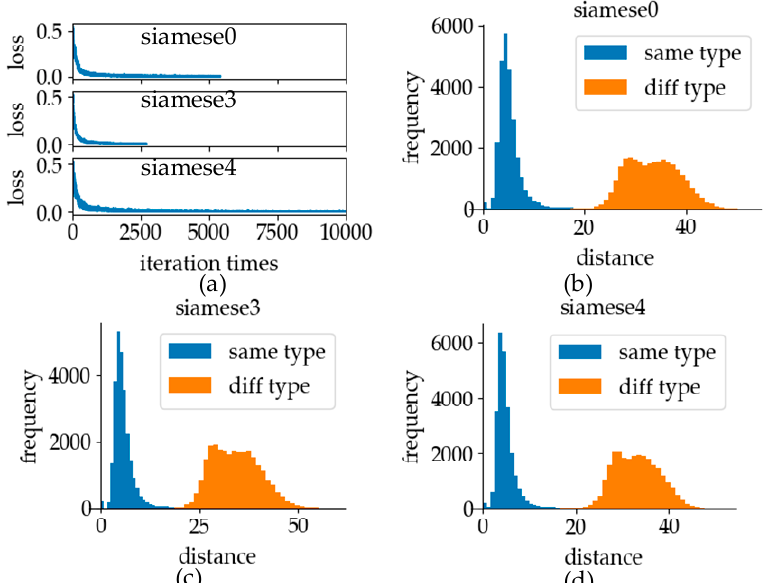
Figure 23. Comparison of the experimental results of network training using different batch sizes. Each of these subgraphs had the same meaning as Figure 21. ( a ) Siamese0 represents the situation of the batch size 512, siamese3 represents 256, and siamese4 represents 128. ( b ) The test results whose batch size was 256. ( c ) The test results whose batch size was 512. ( d ) The test results whose batch size was 128.